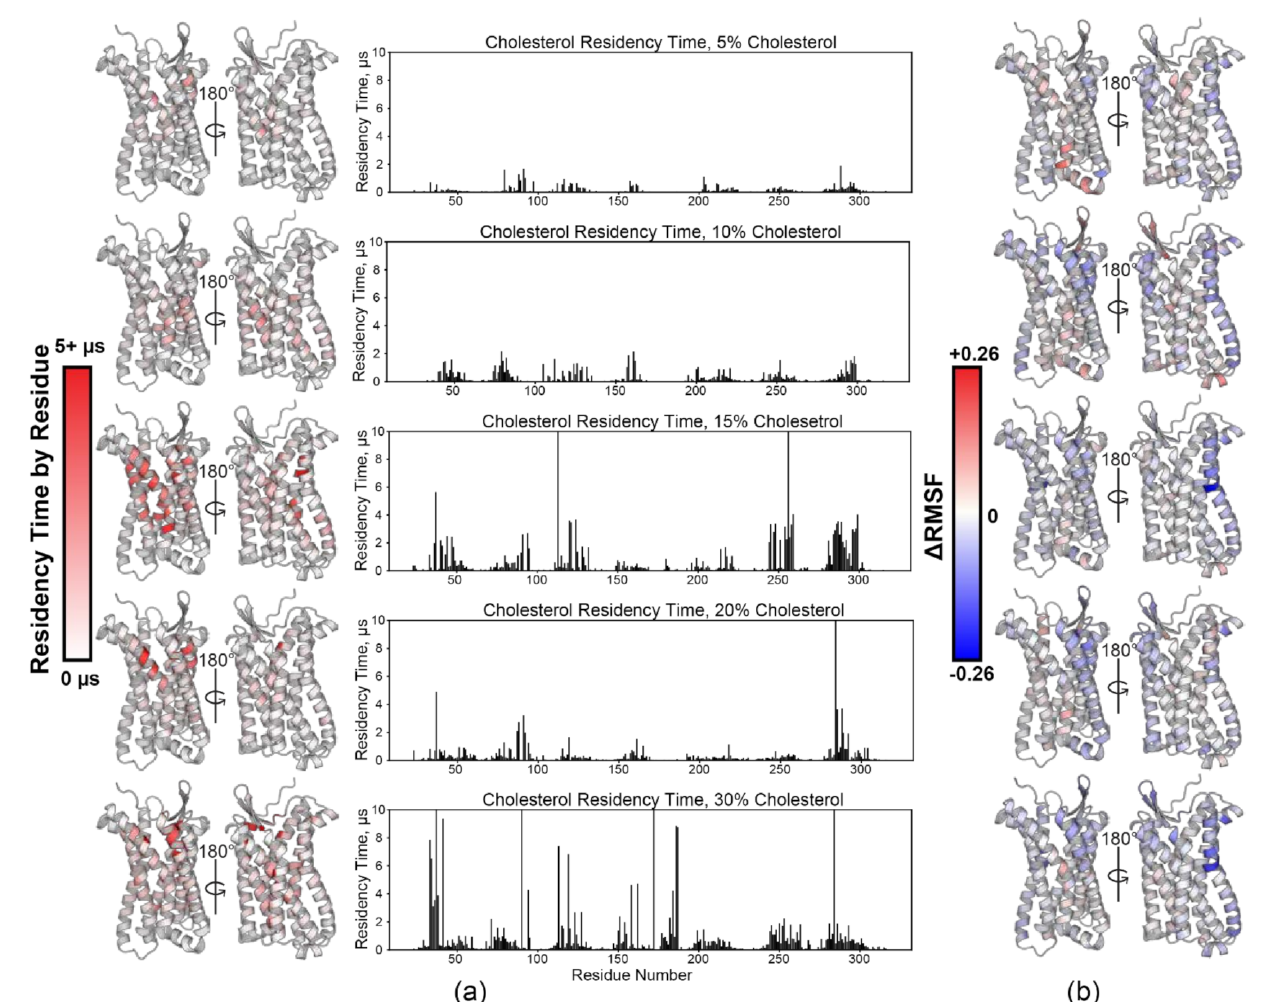
Figure 3. Analysis of cholesterol-titrated Coarse-Grained MD simulations. ( a ) Heatmaps of calculated cholesterol residency times per residue (left) paired with the same values plotted as a function of residue number (right) for the 5% cholesterol simulations (top) through the 30% cholesterol simulations (bottom). ( b ) ∆ Root Mean Square Fluctuation ( ∆ RMSF) calculations reveal sites of structural plasticity (red) and rigidity (blue) mapped onto the model monomer as a function of residue number for the 5% (top) through 30% (bottom) cholesterol